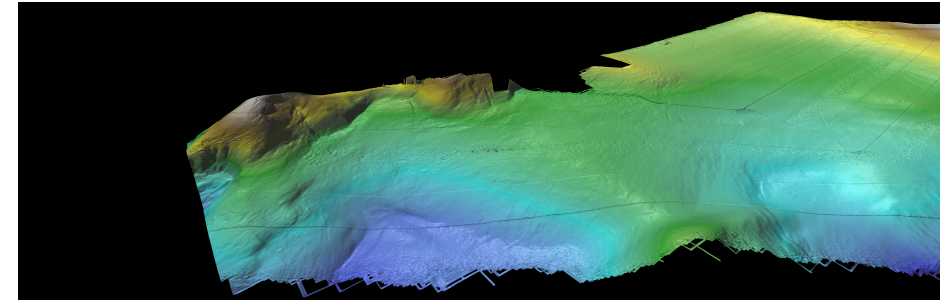
Figure 13. 3D shaded relief of the part of the mapped area at the depth range of 3700–4000 m.